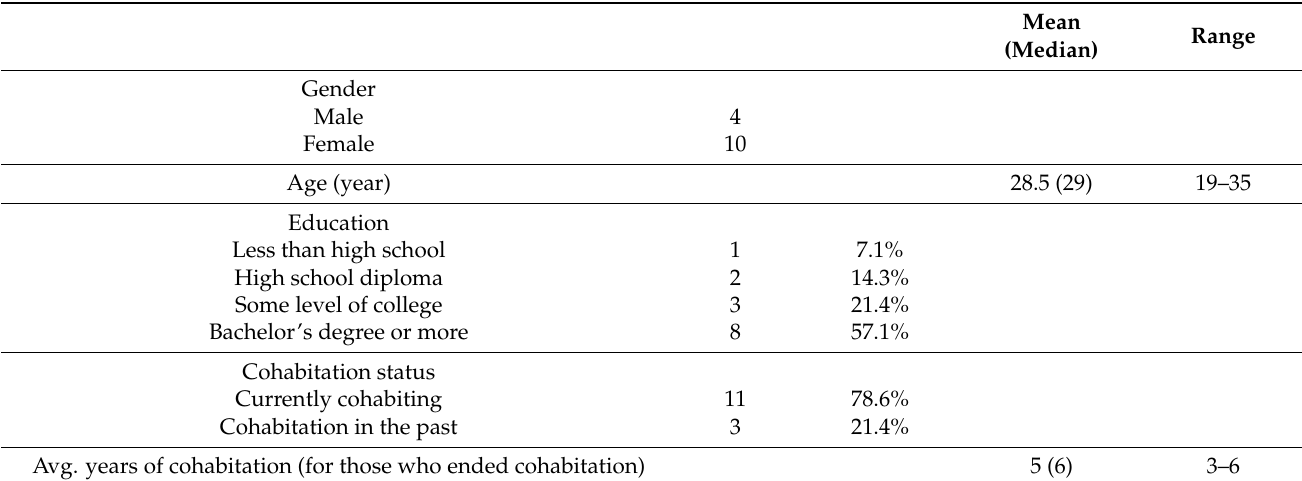
Table 2. Characteristics of sample for the semi-structured interview ( n = 14)